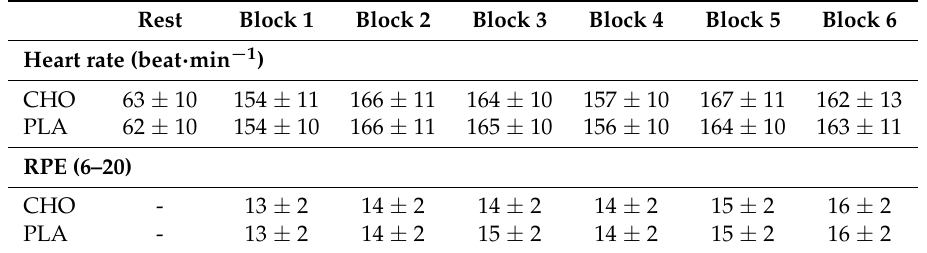
Table 3. Heart rate (beat · min − 1 ) and RPE (6–20) during the LIST for CHO and PLA trials. Rest Block 1 Block 2 Block